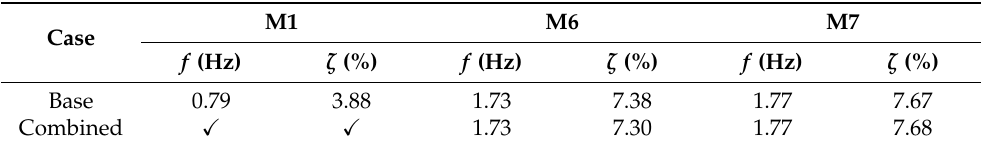
Table 18. Comparison between the base case and the combined contribution of RESs frequency support and PSS tuning to the small signal stability for the Low Load DP. Check marks indicate those modes with a damping factor greater than 10%.